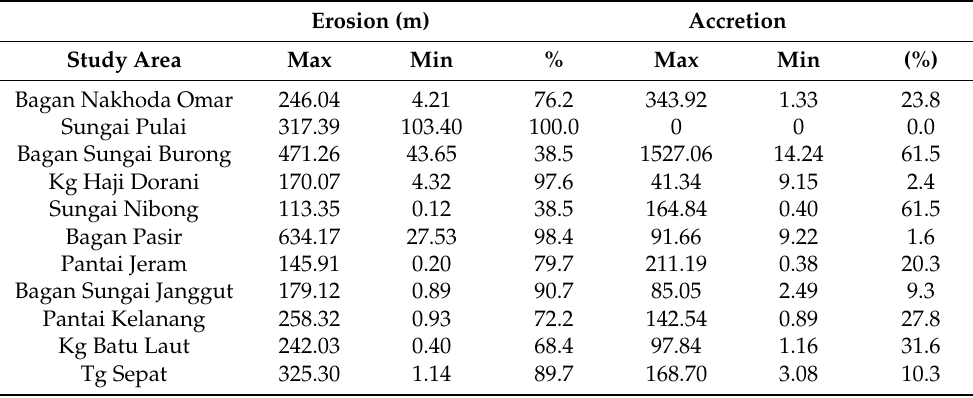
Table 4. Result of the Net Shoreline Movement (NSM) along the study areas. Erosion (m)